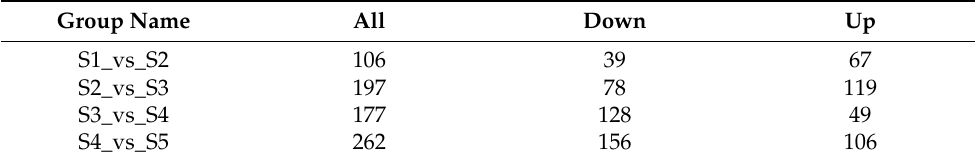
Table 1. Statistical table of significantly different